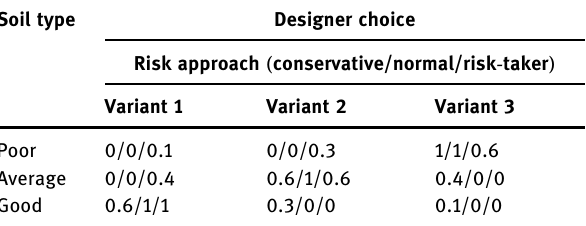
Table 2: Three approaches towards risk were analysed for the designer who performs the selection of the soil strengthening variant based on the empirical data depending on soil strength analysis, original work based on ref. [ 16